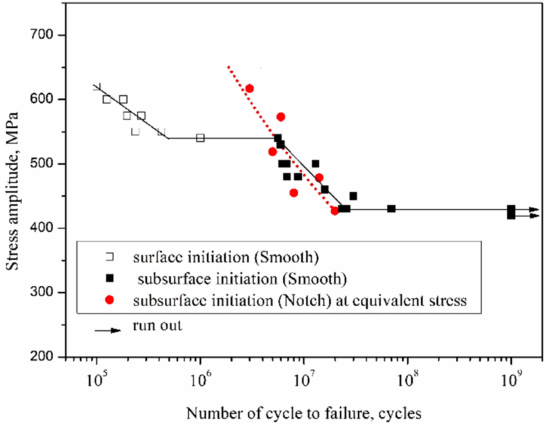
Figure 14. S–N curves of smooth specimens and notched specimens for equivalent